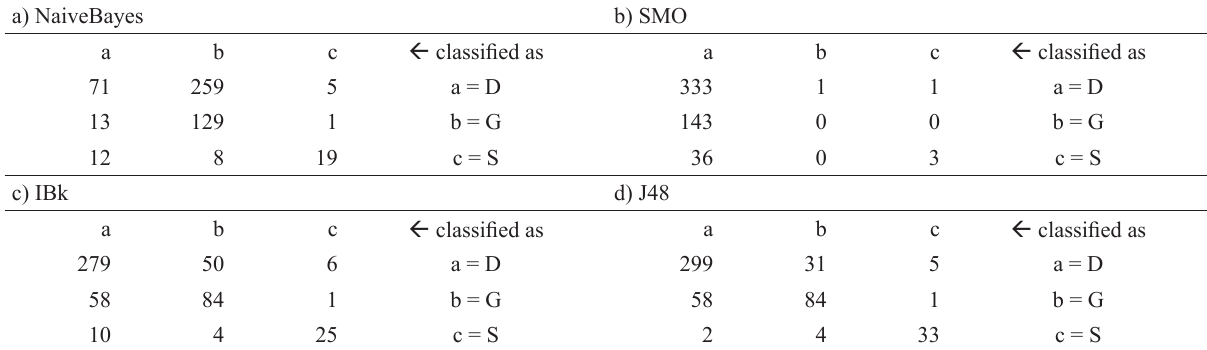
Table 1. Confusion matrices after applying a, NaiveBayes; b, SMO; c, IBk; d, J48 algorithms. Columns indicate the classification made by the algorithm, whereas rows correspond to the real classification. Correctly classified instances are those that occupy the central diagonal. Abbreviations are: D, dolomite; G, gypsum; S,